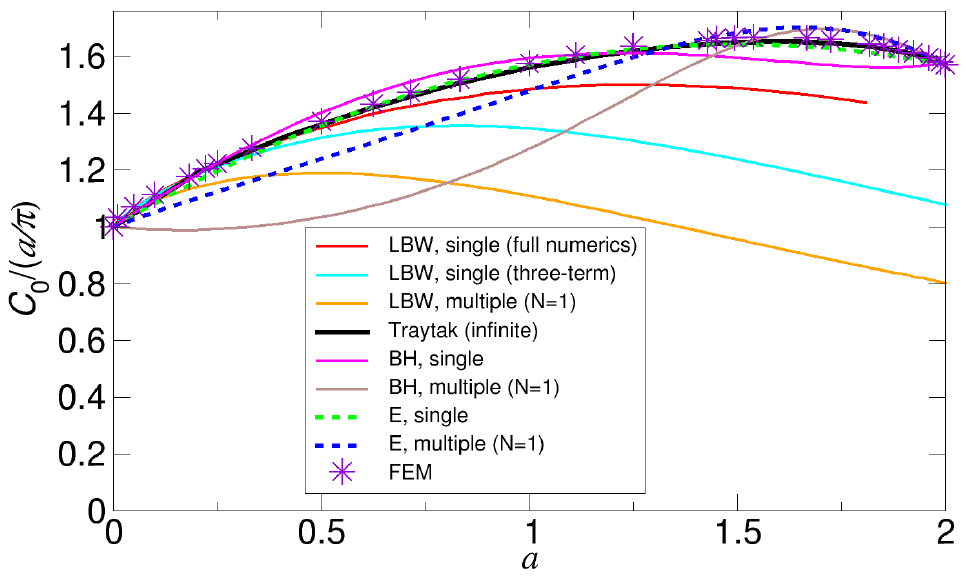
Figure A1. Comparison of the rescaled capacitances C 0 / ( a / π ) for a single patch as functions of patch radius a . Figure 5 (a) of Reference [35] provides the results calculated from the LBW formulas for a single patch with an infinite series (LBW, single (full numerics)) and with a finite series up to three terms (LBW, single (three-term)). We also calculate the rescaled capacitance using the formula (Equation (4)) for multiple patches with 𝑁 = 1 (LBW, multiple (N = 1)). Note that the interaction function ℋ defined in Reference [35], introduced in the derivation of Equation (4), gives 1/8 for 𝑁 = 1, which is supposed to be zero for 𝑁 = 1. The Traytak result with infinite-order calculation is from Reference [49]. The results from the BH theory are obtained from the formulas for a single patch and